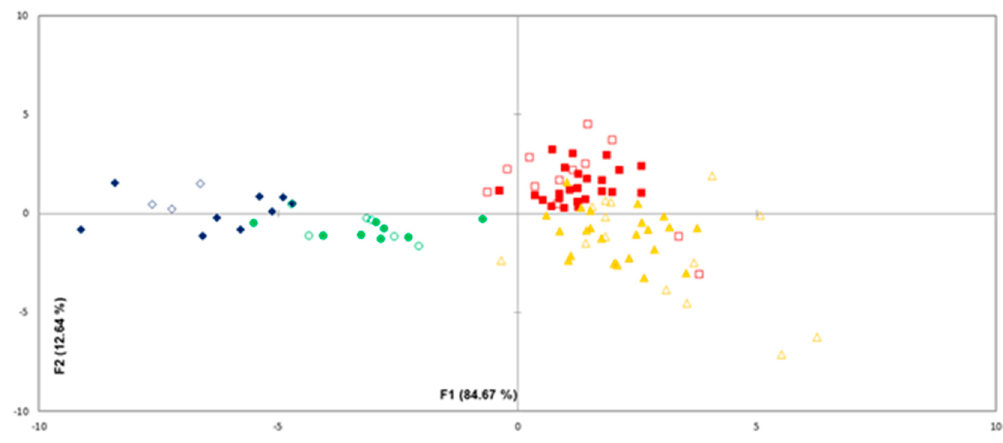
Figure 4. Discriminant analysis similarity map for the di ff erent microbial groups ( (cid:7) ): sterile meat, ( (cid:78) ): meat inoculated with microbial species of pseudomonads, ( (cid:4) ): meat inoculated with microbial species of LAB and ( • ): meat inoculated with a cocktail culture of 4 strains stored at 4 and 10 ◦ C, as determined by the first two discriminant functions. Empty and filled symbols indicate the validation and training samples, respectively.